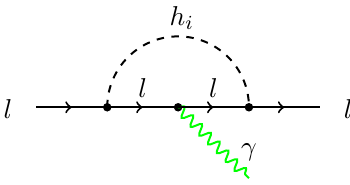
Figure 1 . The higher order diagrams contributing to muon anomalous magnetic moment ( l = (cid:22) ) and to e EDM ( l = e ).